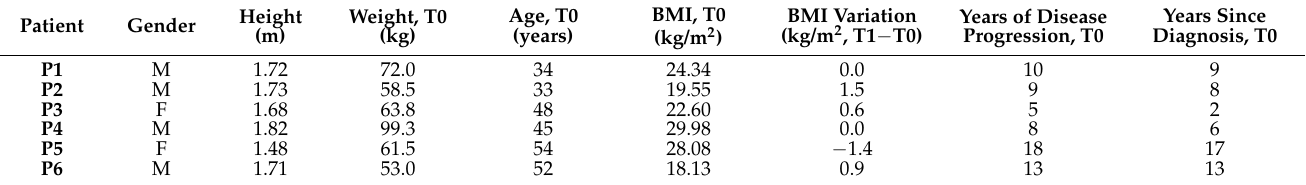
Table 1. Demographics and clinical data for each patient that participated in the experiment.